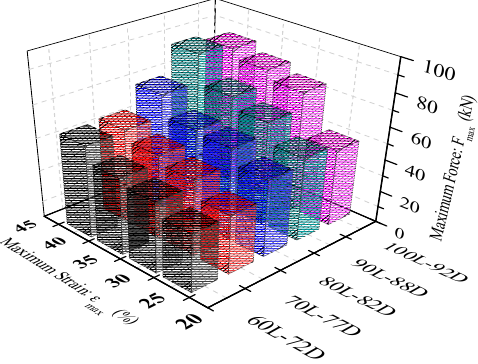
Figure 8. Relationship between maximum strain and maximum force. Table 3. Regression between maximum strain and force in Type 1. Specimen